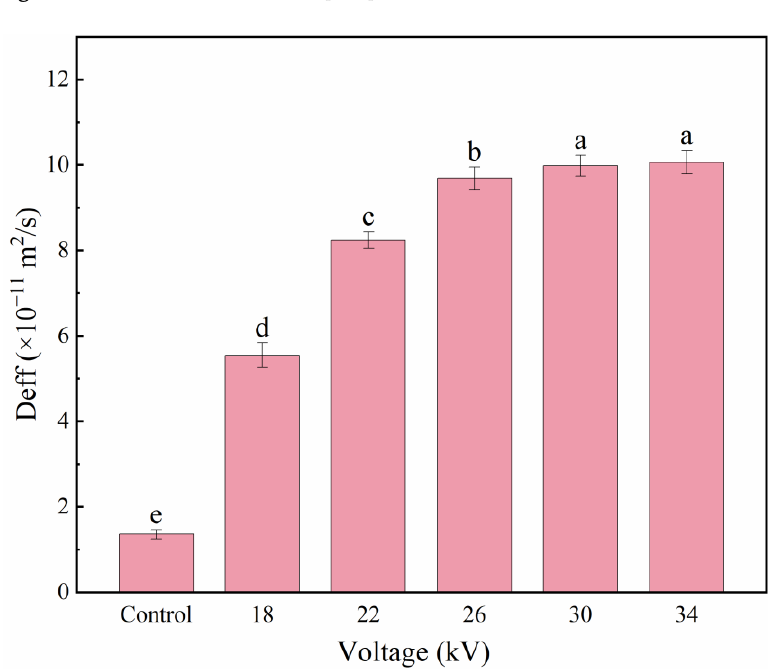
Figure 5. 𝐷 𝑒𝑓𝑓 of shiitake mushroom slices. Different letters indicate significant differences ( p < 0.05) between sample means.